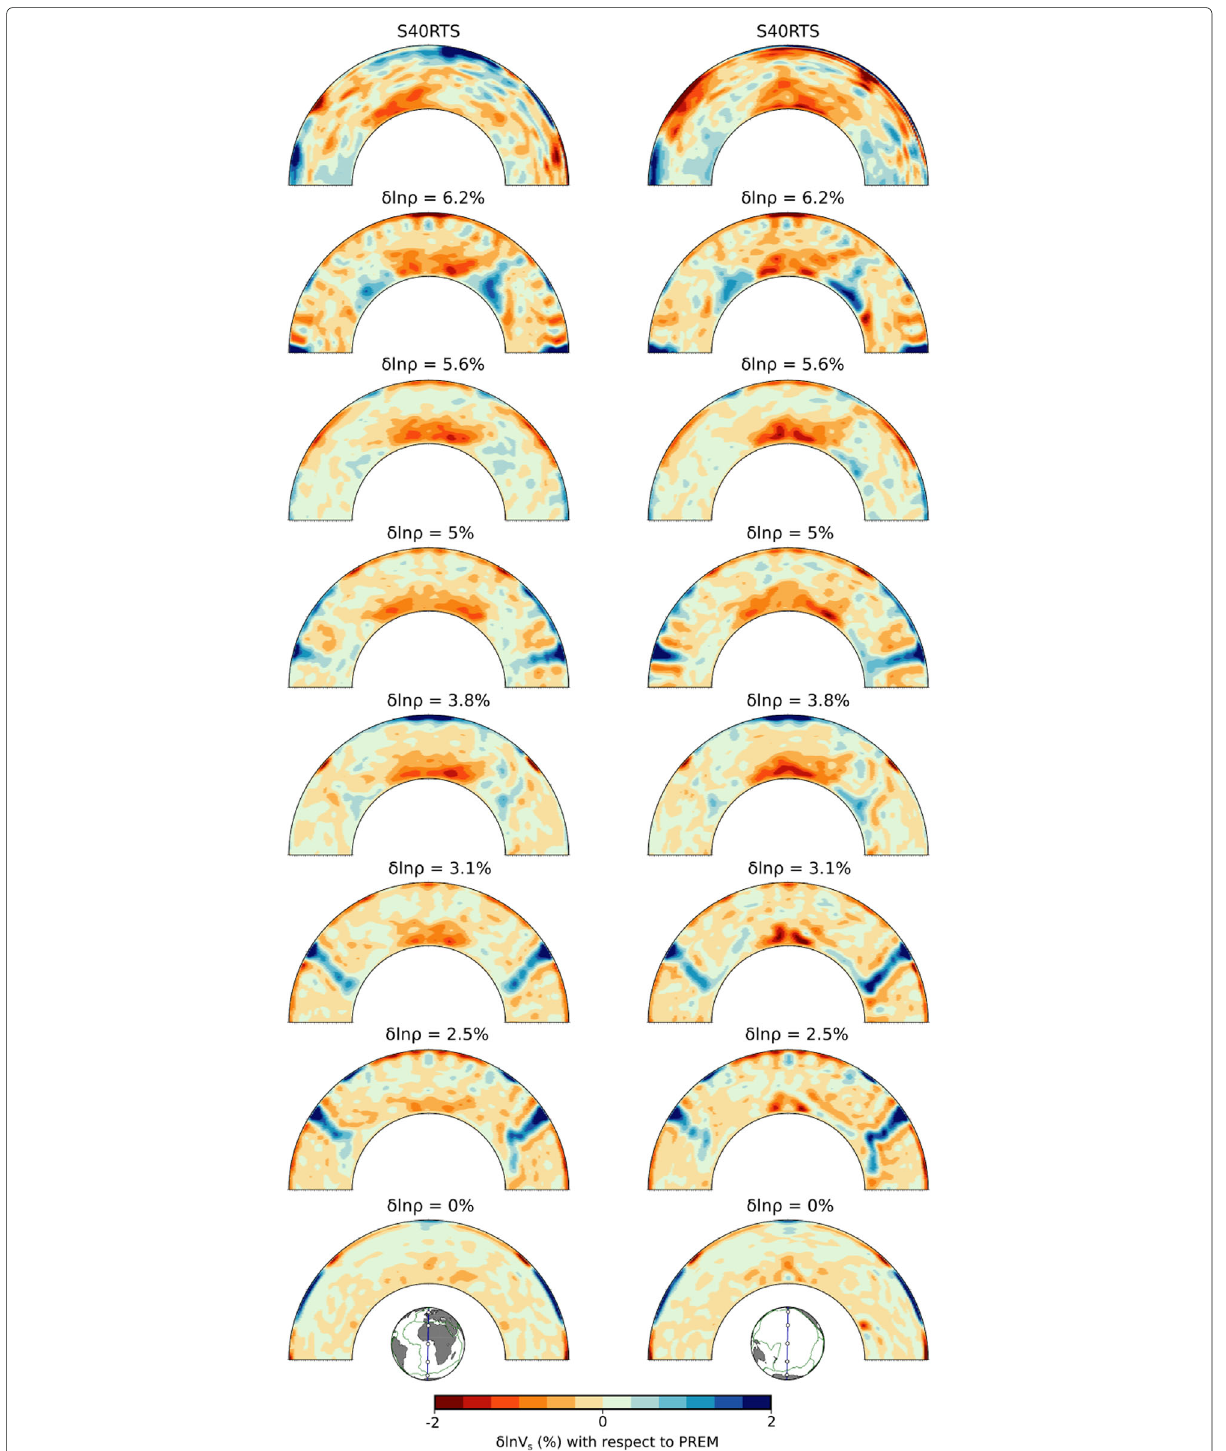
Fig. 4 Top row: cross-sections through S40RTS beneath the African (left column) and Pacific (right column) plates. Each subsequent row is a cross-section through the recovered δ lnV s for dynamic models with different densities for the basaltic component after tomographic filtering. Geographic location of depth slice is provided in by the black vertical line through the globe. Broad low δ lnV s structures form in models where δρ ≥ 3.1%. In many cases, high velocity features, which map onto recently subducted lithosphere, flank the low δ lnV